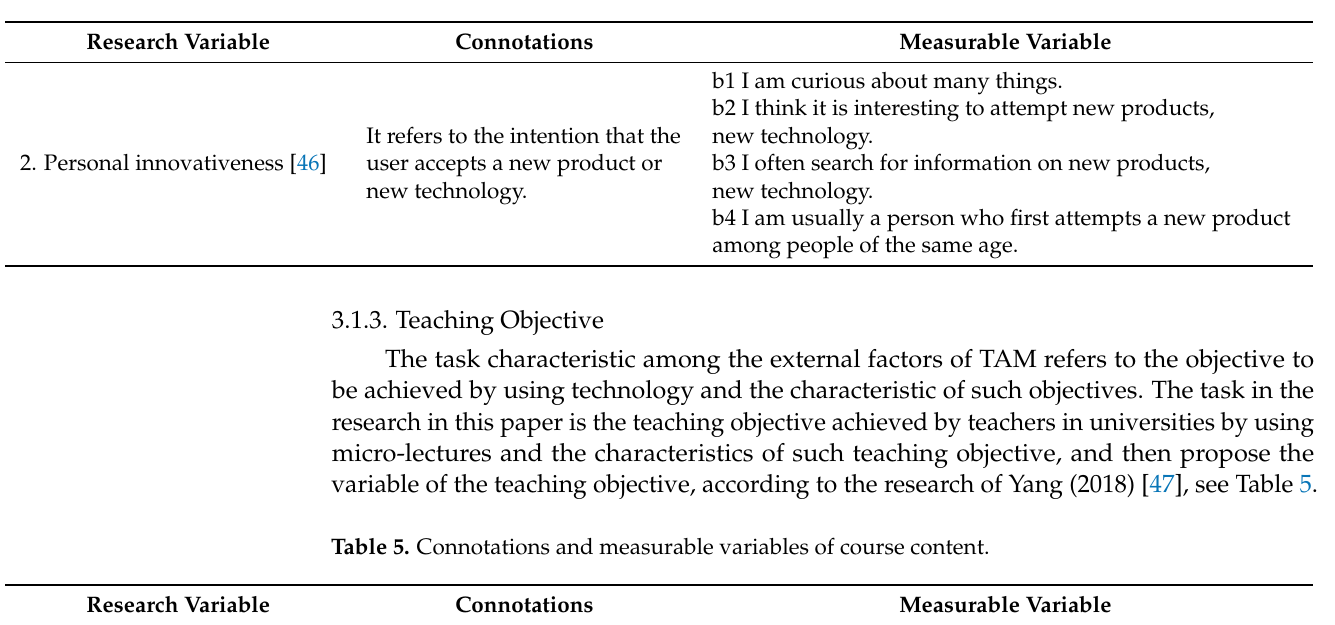
Table 4. Connotations and measurable variables of personal innovativeness.